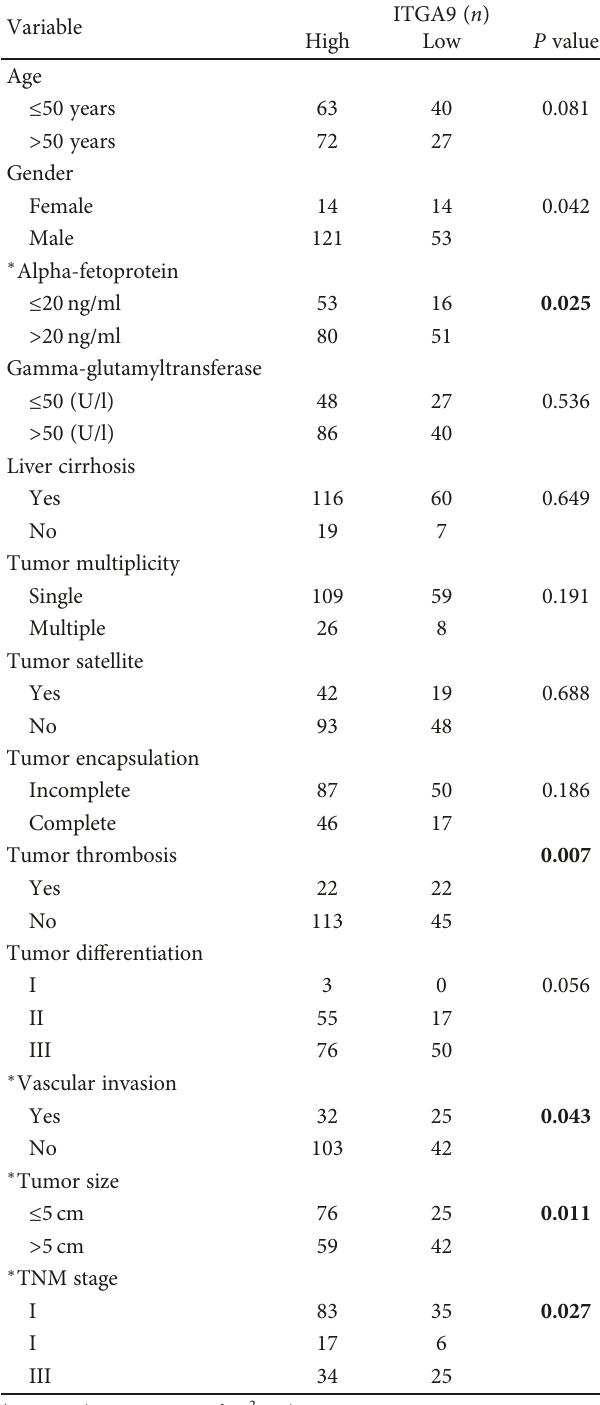
Table 1: Correlation of clinicopathological features with ITGA9